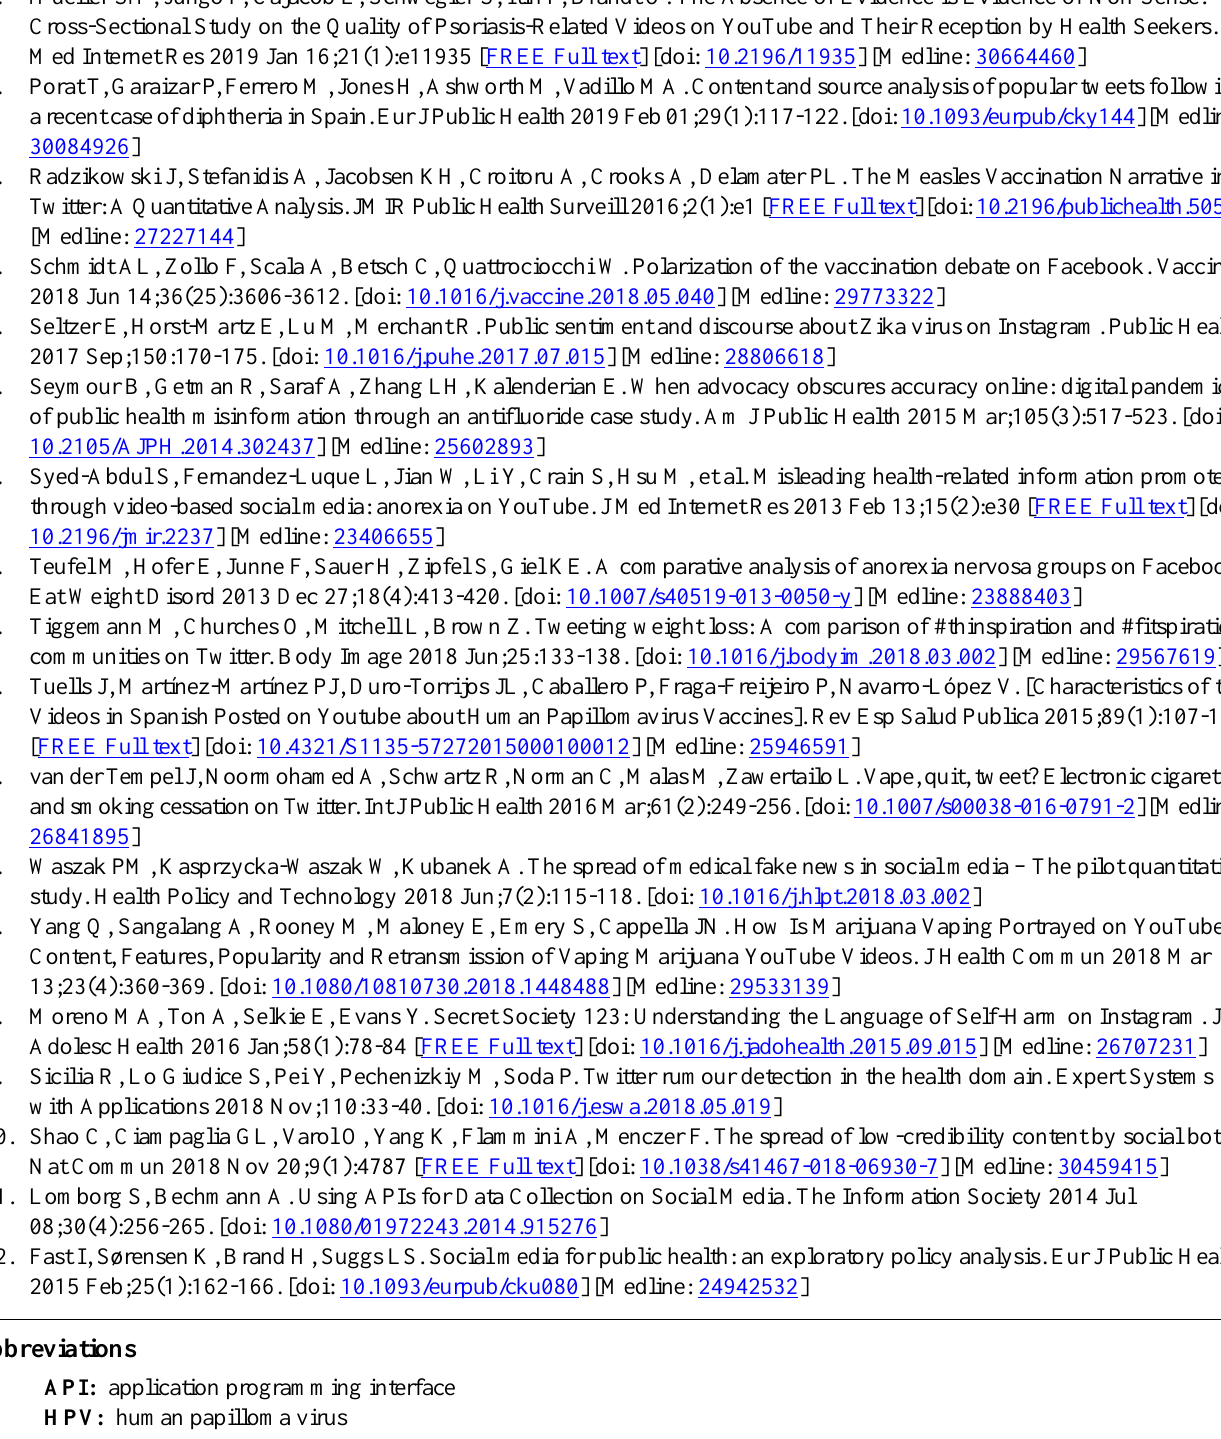
API: application programming interface HPV: human papilloma